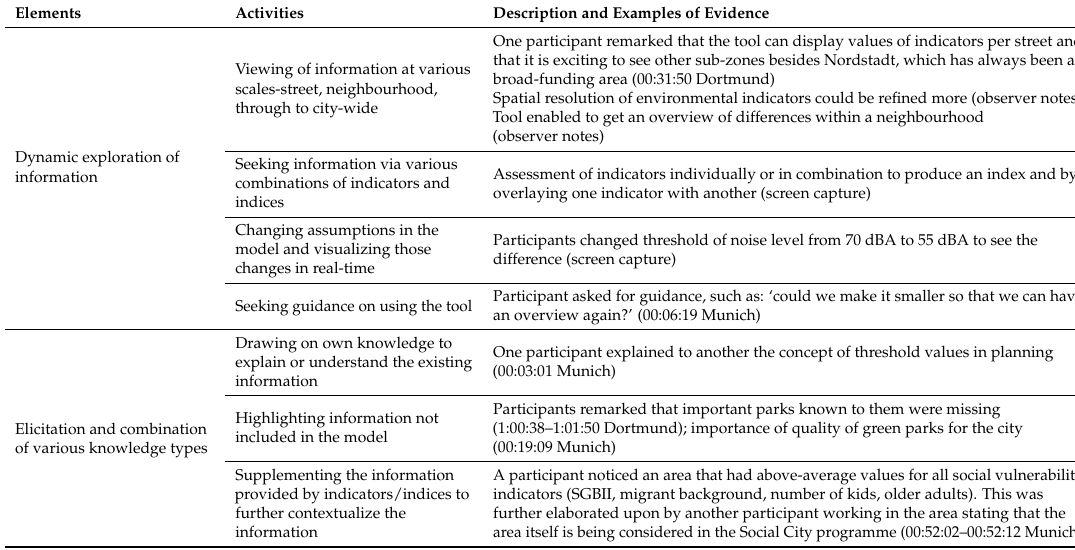
Evidence on information support provided by our interactive stakeholder-based CuBA